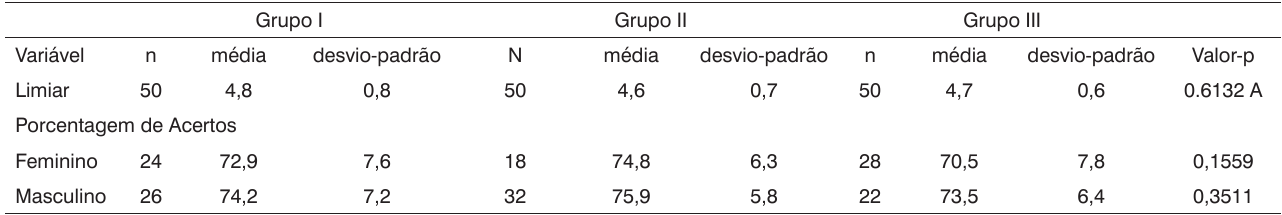
Tabela 6. Descrição da média e desvio padrão dos limiares de de- tecção de gap (em ms) e porcentagem de acertos independente de orelha, gênero e